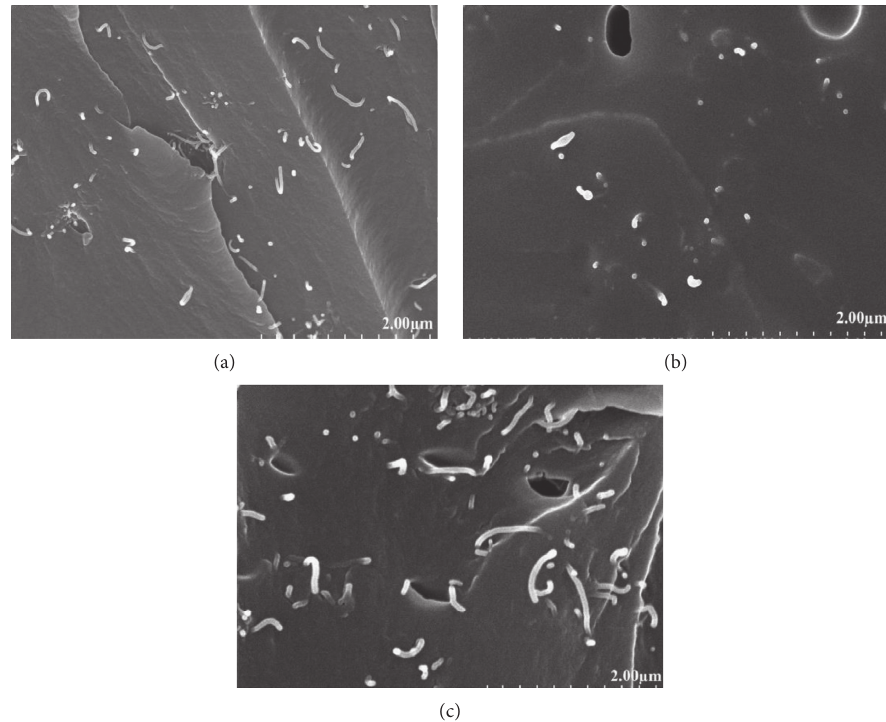
Figure 6: SEM images of nanocomposites fly ash/MWCNTs/epoxy: (a) 40 wt.% fly ash/0.04 wt.% MWCNTs/epoxy; (b) 40 wt.% fly ash/0.03 wt.% MWCNTs/epoxy; and (c) 40 wt.% fly ash/0.05 wt.% MWCNTs/epoxy.